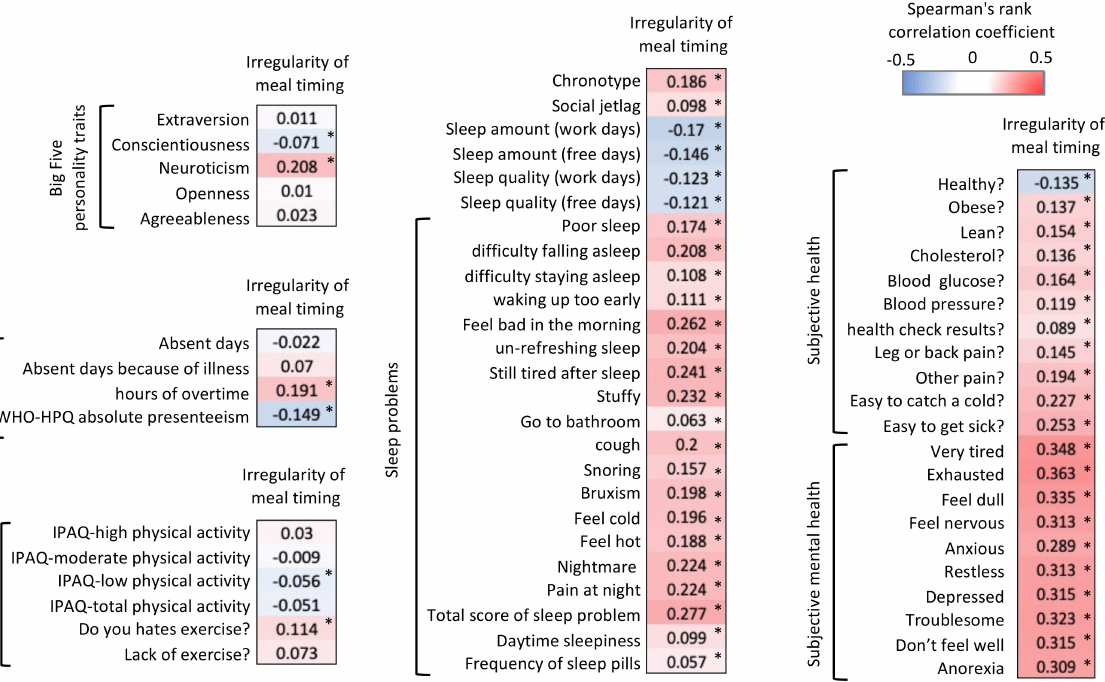
Figure 1. Spearman’s correlation analysis of “irregularity of meal timing” and other factors, indicated by the correlation coefficient values with gradient color in each column. Asterisks (*) in each column also indicate the significance of correlation ( p <